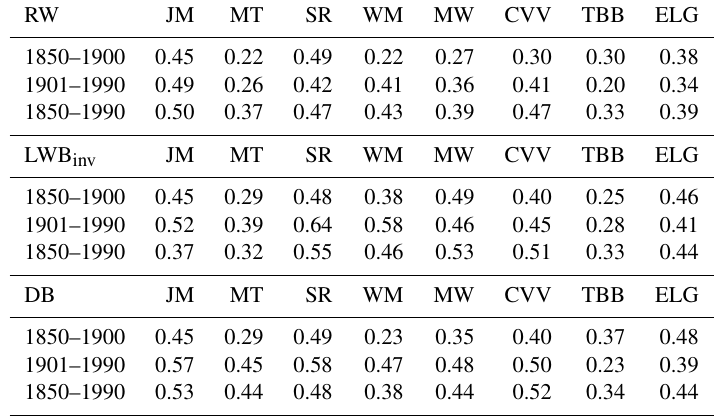
Table 2. Correlations (1850–1900, 1901–1990, and 1850–1990) for each site RW, LWB inv , and DB chronology with JJAS temperatures. EWB correlations are not shown. The sites are ordered from east to west (see Fig. 1). RW JM MT